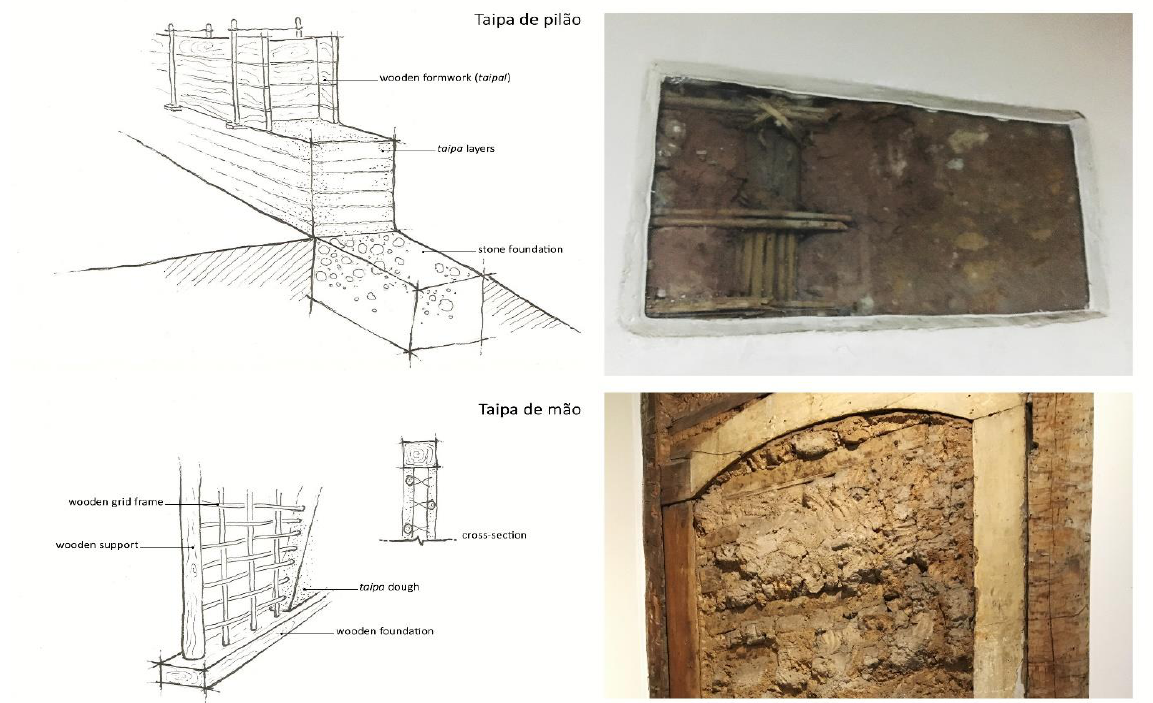
Figure 3. (Right) Constructive drawings of the two main masonry detail: taipa de pilao and taipa de mao; (left) two example of taipa masonry that can be seen in San Paolo city, on the top Igreja de Santo Antônio, lower the Solar da Marquesa